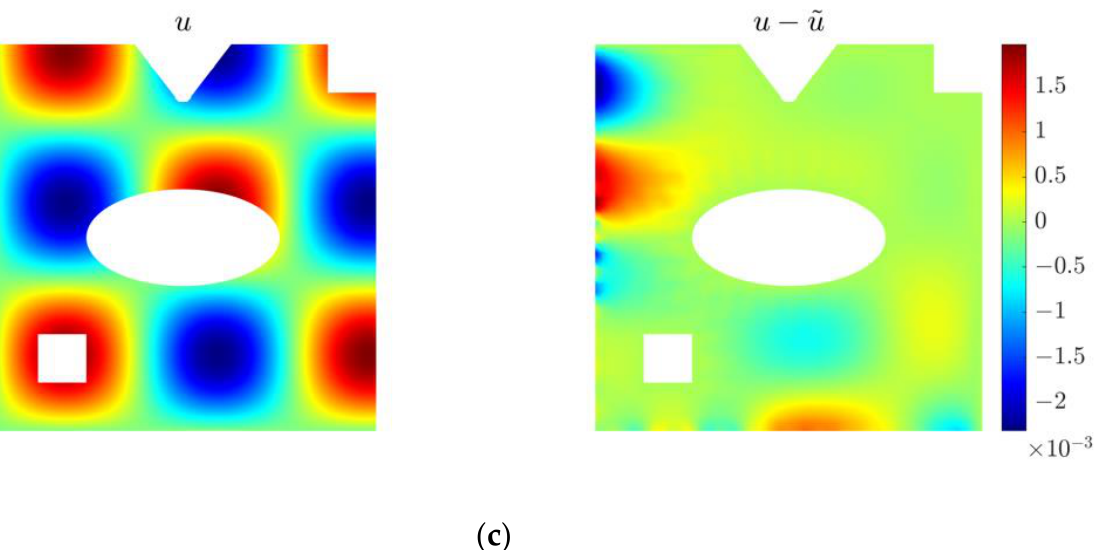
Figure 9. Solution and corresponding error for the 2D constant parameter identification problem in irregular geometry under different discretizations: ( a ) N s = 11 × 11; ( b ) N s = 21 × 21 ; ( c ) N s = 31 × 31.